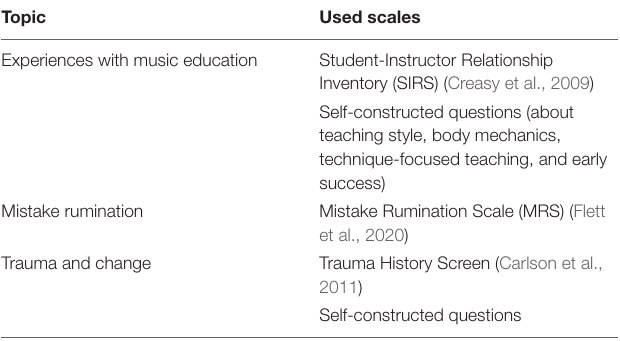
TABLE 3 | Topics and scales.